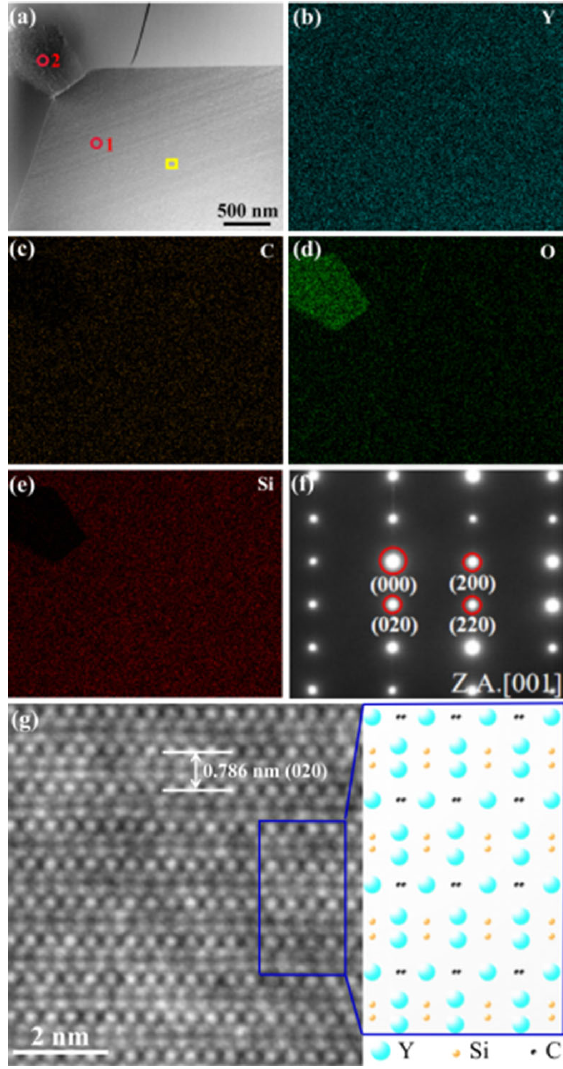
Fig. 5 TEM image of Y 3 Si 2 C 2 ceramics sintered at 1500 ℃ : (a) HAADF image and elemental distribution of (b) Y, (c) C, (d) O, (e) Si; (f) SAED pattern for the yellow area in (a); (g) high resolution transmission electron microscopy (HRTEM) image of Y 3 Si 2 C 2 , the insert includes structure models showing the positions of Y, Si, and C. HRTEM image and corresponding SAED parten were confirmed along the [001] zone